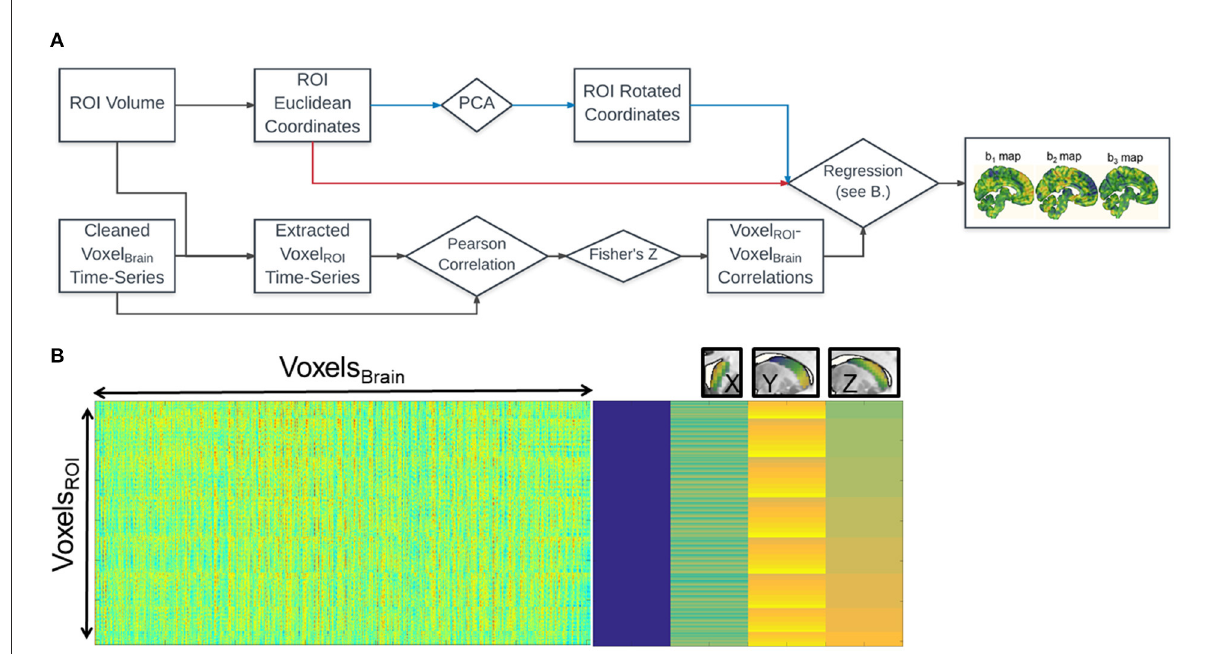
FIGURE1 Fine Relational Spatial Topography (FiRST) approach. (A) Analysis pipeline. Squares denote measurements and diamonds denote operations. The voxel wise time-series from the entire brain (Voxel Brain ) are correlated with the voxel wise time-series of the ROI (Voxel ROI ). The resultant k × n matrix (where k = number of voxels in the ROI, and n = number of voxels in the brain) is then regressed against the x, y, z coordinate space of the ROI, either in Euclidean coordinates or their corresponding rotated values derived from PCA (red or blue arrows in the flowchart). This regression produces 3 beta maps, denoting preference in connectivity along a particular directional gradient along the ROI (b 1 for M-L, b 2 for A-P, b 3 for D-V). (B) The visualization of the design matrix for the regression analysis. The rightmost side is equivalent to the conventional SPM design matrix for the ROI’s x, y, z coordinates, while the leftmost side is the input into the regression. Right above the design matrix illustrates the three orthogonal caudate